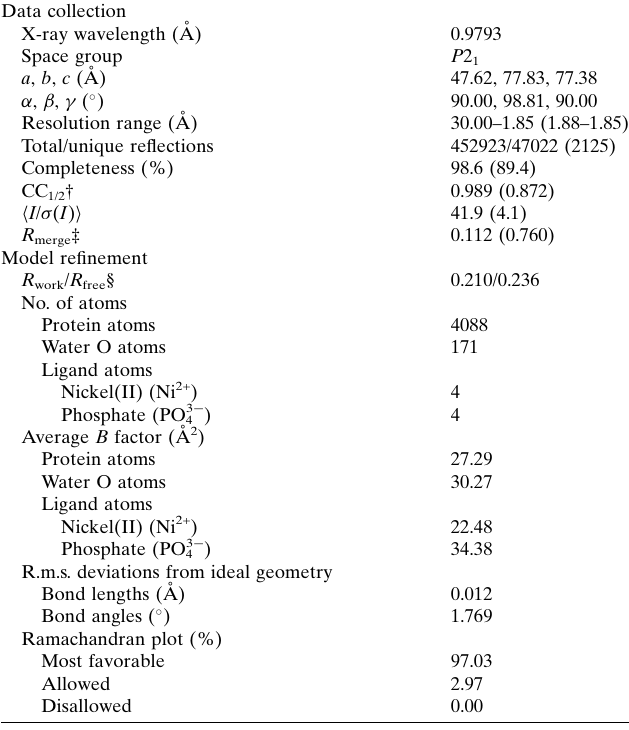
Table 1 Data-collection and model-refinement statistics for SeMet-derived Sa TatD (PDB entry 6l25). Values in parentheses are for the highest resolution